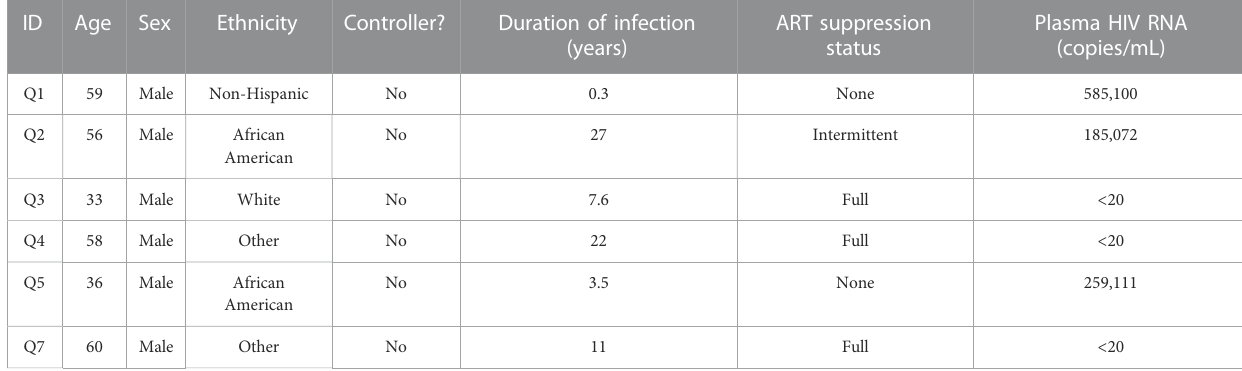
TABLE 3 Characteristics of selected data from HIV + individuals from Wang et